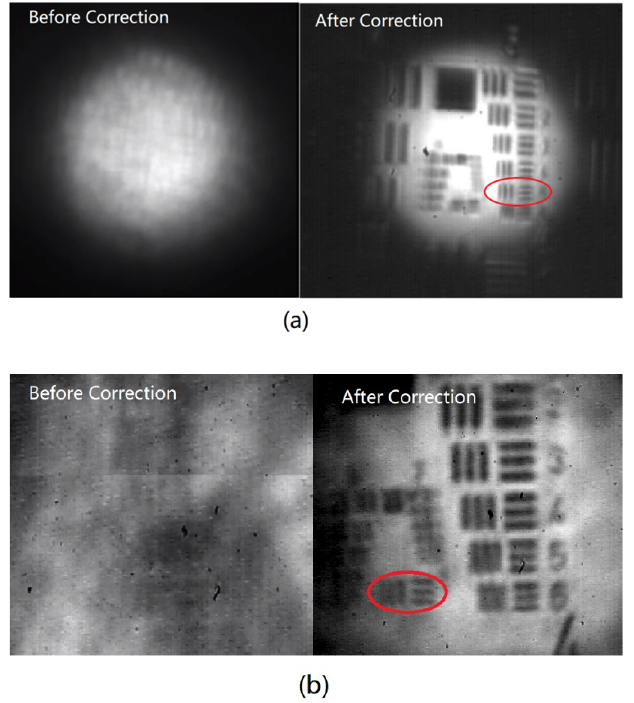
Figure 8. Infrared band resolution plate imaging: ( a ) 1.5–1.7 µ m; ( b ) 950–1500 nm. (The clearest line pair has been circled in red).